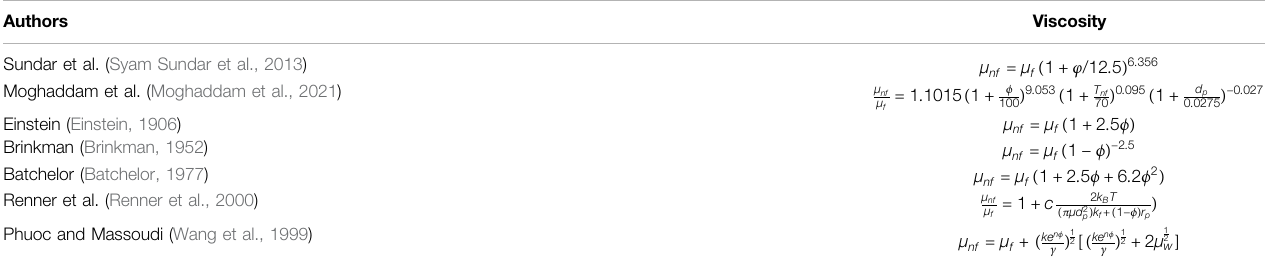
TABLE 3 | Calculation models of nano fl uid